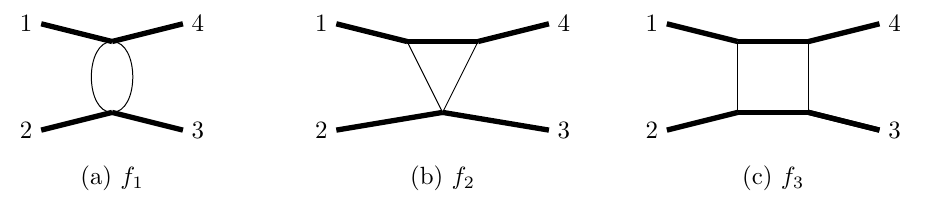
Figure 9. Topologies for the box master